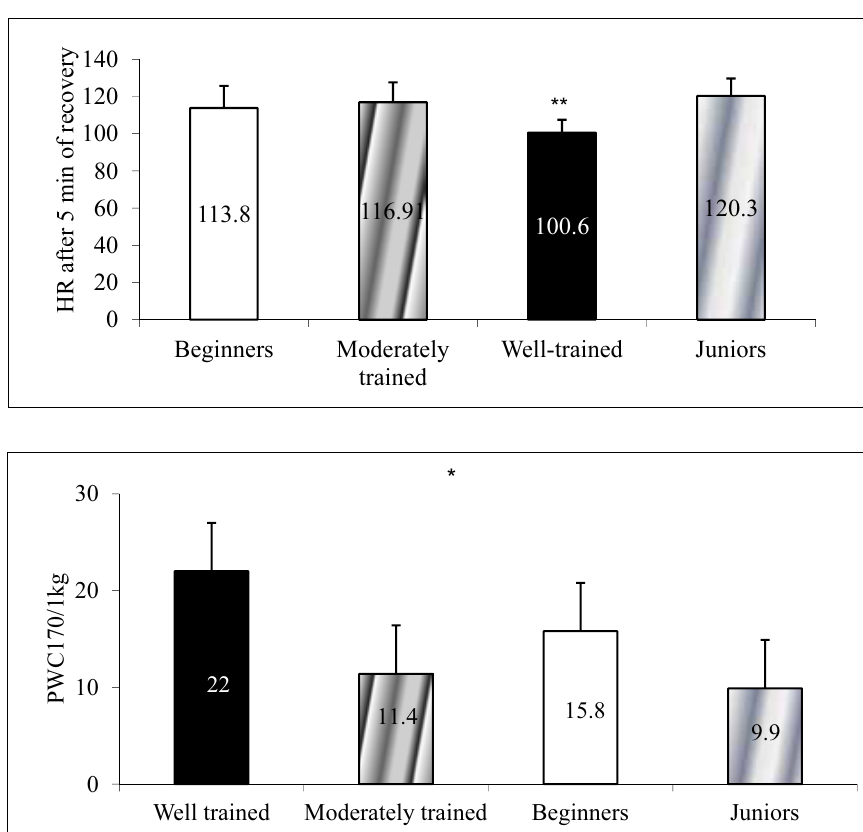
Figure 2. HR values of aerobic gymnastics athletes during recovery